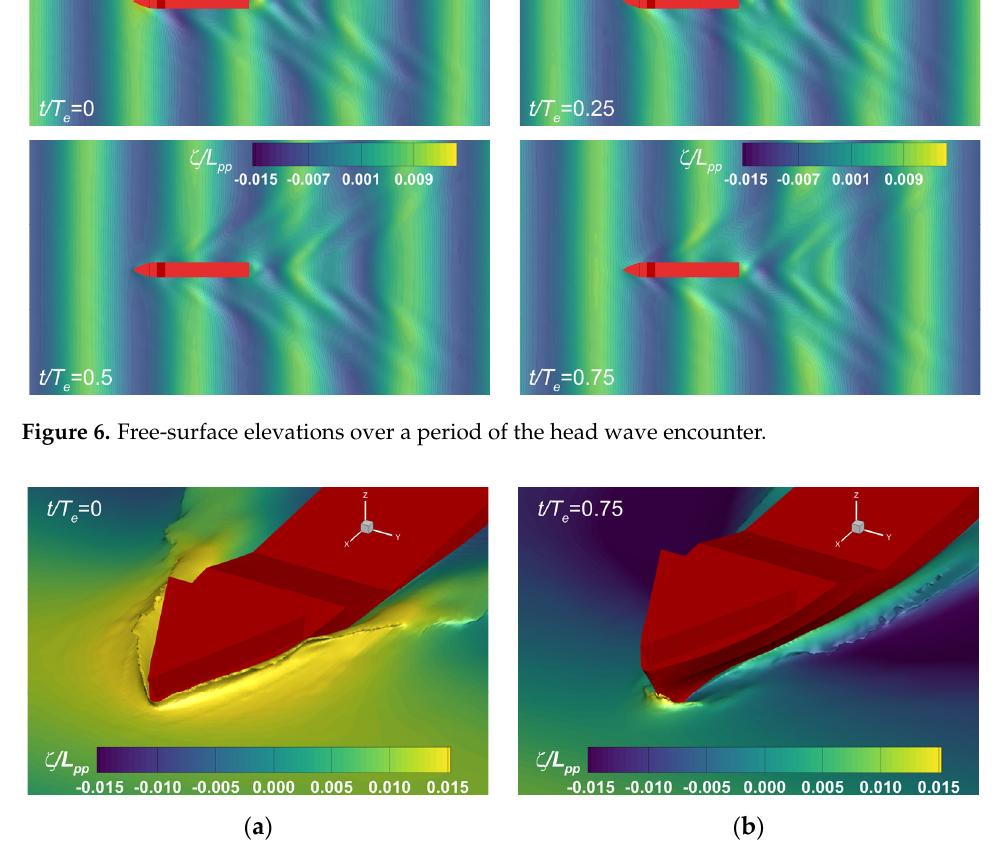
Figure 6. Free-surface elevations over a period of the head wave encounter.